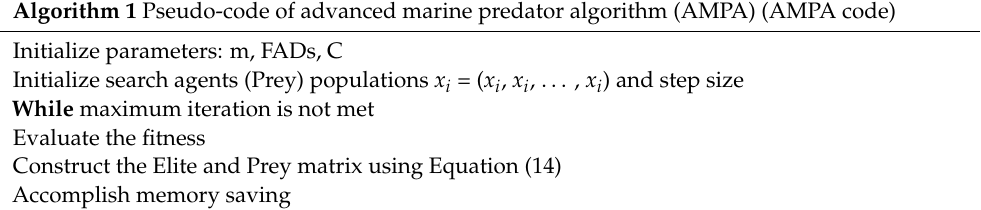
Algorithm 1 Pseudo-code of advanced marine predator algorithm (AMPA) (AMPA